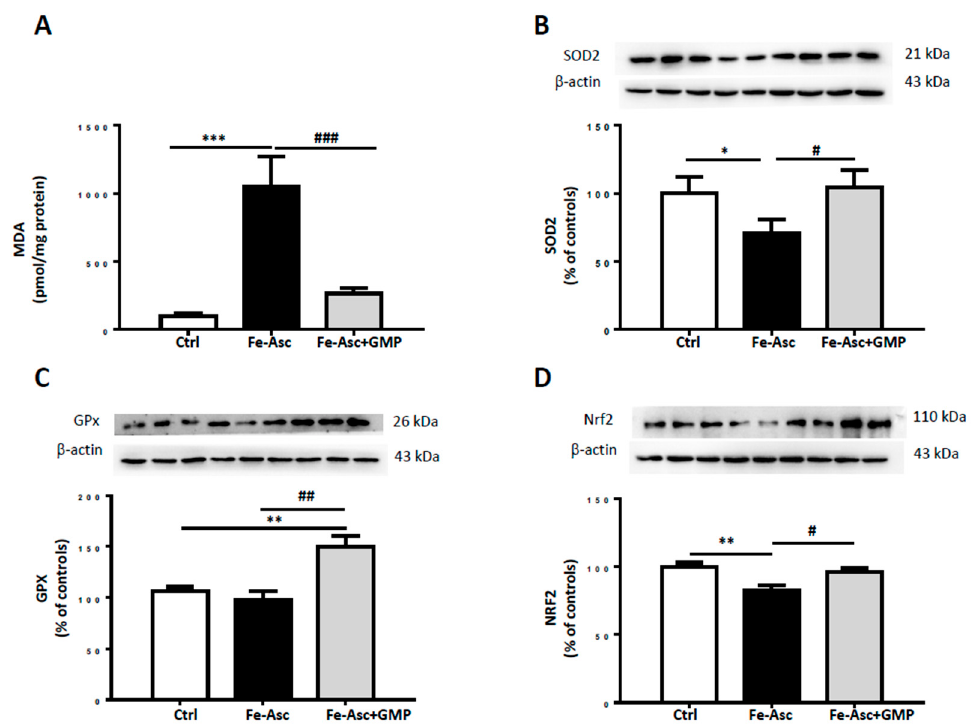
Figure 2. E ff ects of GMP on lipid peroxidation and antioxidant defense in Caco-2 / 15 cells. Caco-2 / 15 cells were pre-incubated for 18 h before treatment with Fe / Asc (200 µ M / 2 mM) +/ − GMP (2 mg / mL) for 6 h at 37 ◦ C as described in Materials and Methods. ( A ) Levels of malondialdehyde (MDA), a biomarker of lipid peroxidation, were measured in cell lysates. Protein expression of the anti-oxidative markers ( B ) superoxide dismutase 2 (SOD2), ( C ) glutathione peroxidase (GPx), and ( D ) nuclear factor erythroid 2–related factor 2 (Nrf2) was determined by Western blot. Results represent the means ± SEM of n = 3 independent experiments in triplicate. * p < 0.05, ** p < 0.01, *** p < 0.001 vs. controls (Ctrl). # p < 0.05, ## p < 0.01, ### p < 0.001 vs. Fe / Asc-treated cells.